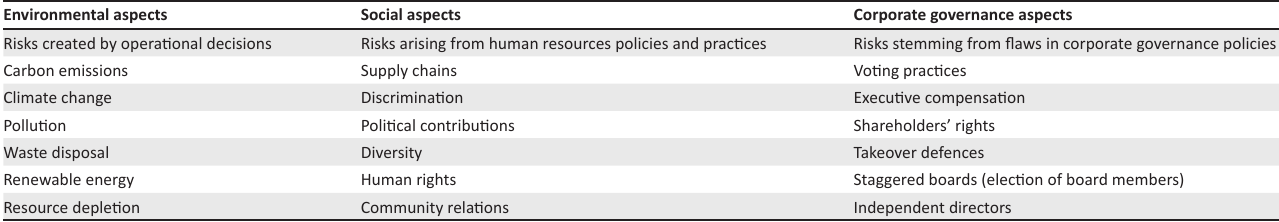
TABLE 1: Bloomberg’s environmental, social and corporate governance considerations.